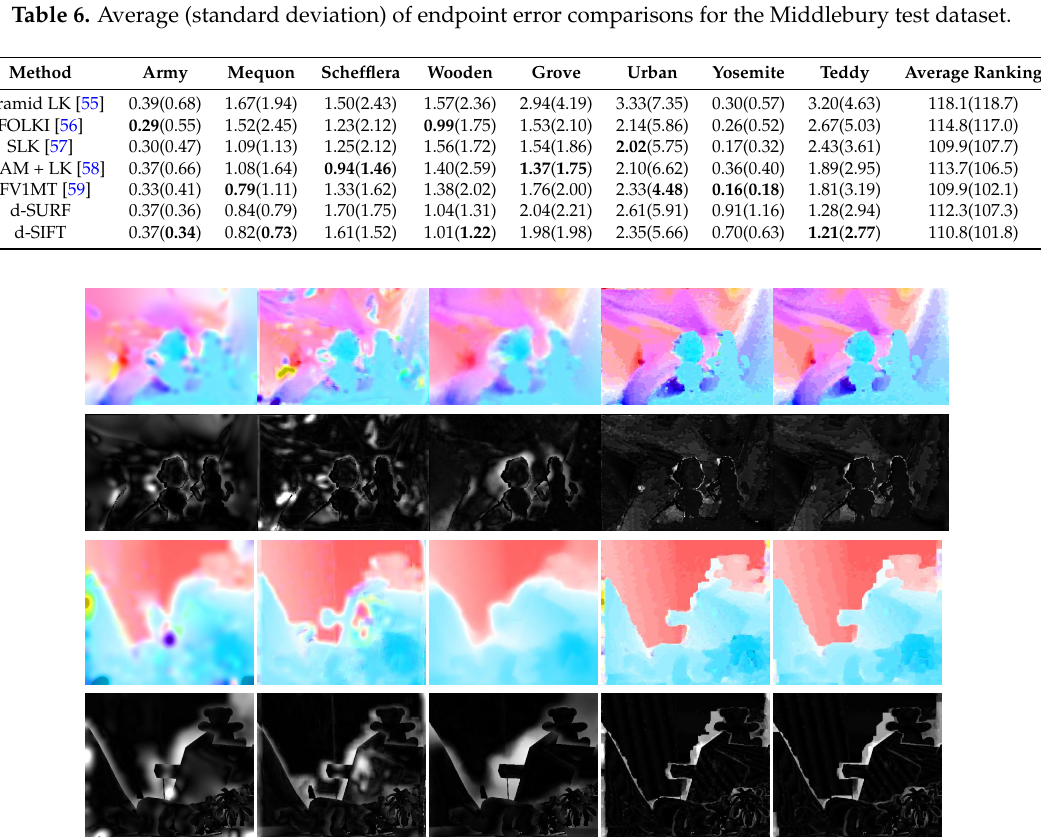
Figure 6. Sample results of the optical flow estimation for two of the test image sets from Middlebury Mequon and Teddy , as well as the flow error, using SLK [57] (first column), PGAM + LK [58] (second column), FFV1MT [59] (third column), d-SURF (fourth column) and d-SIFT (fifth